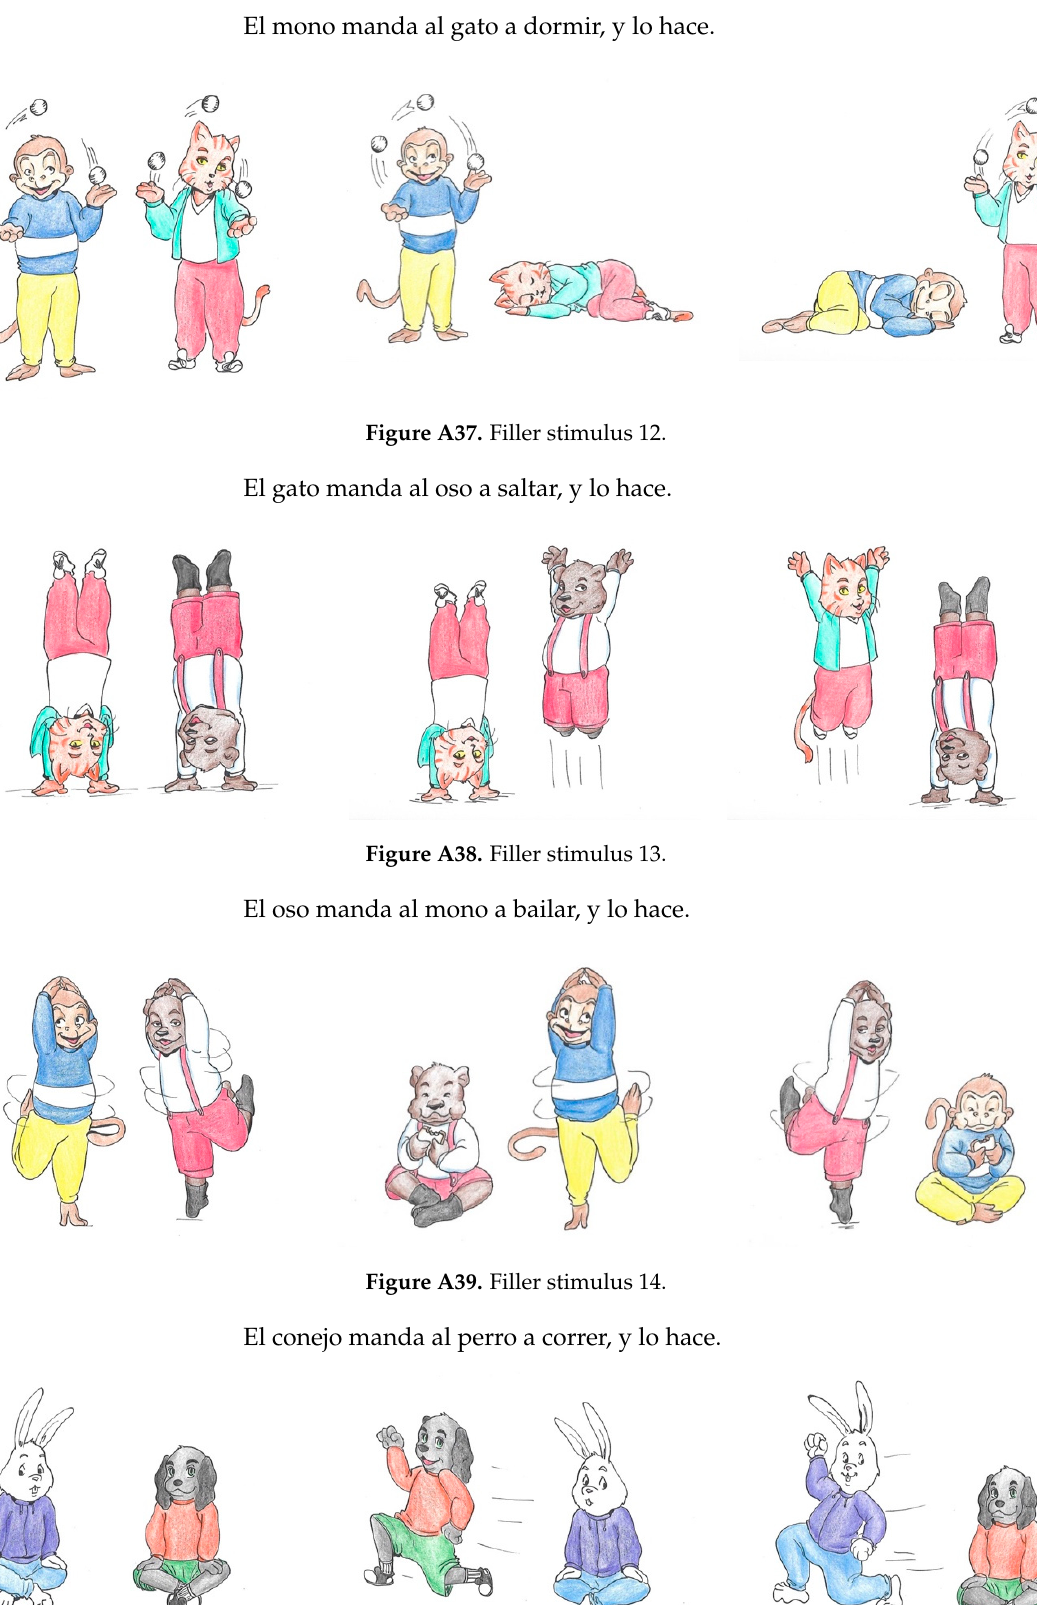
Figure A36. Filler stimulus 11.